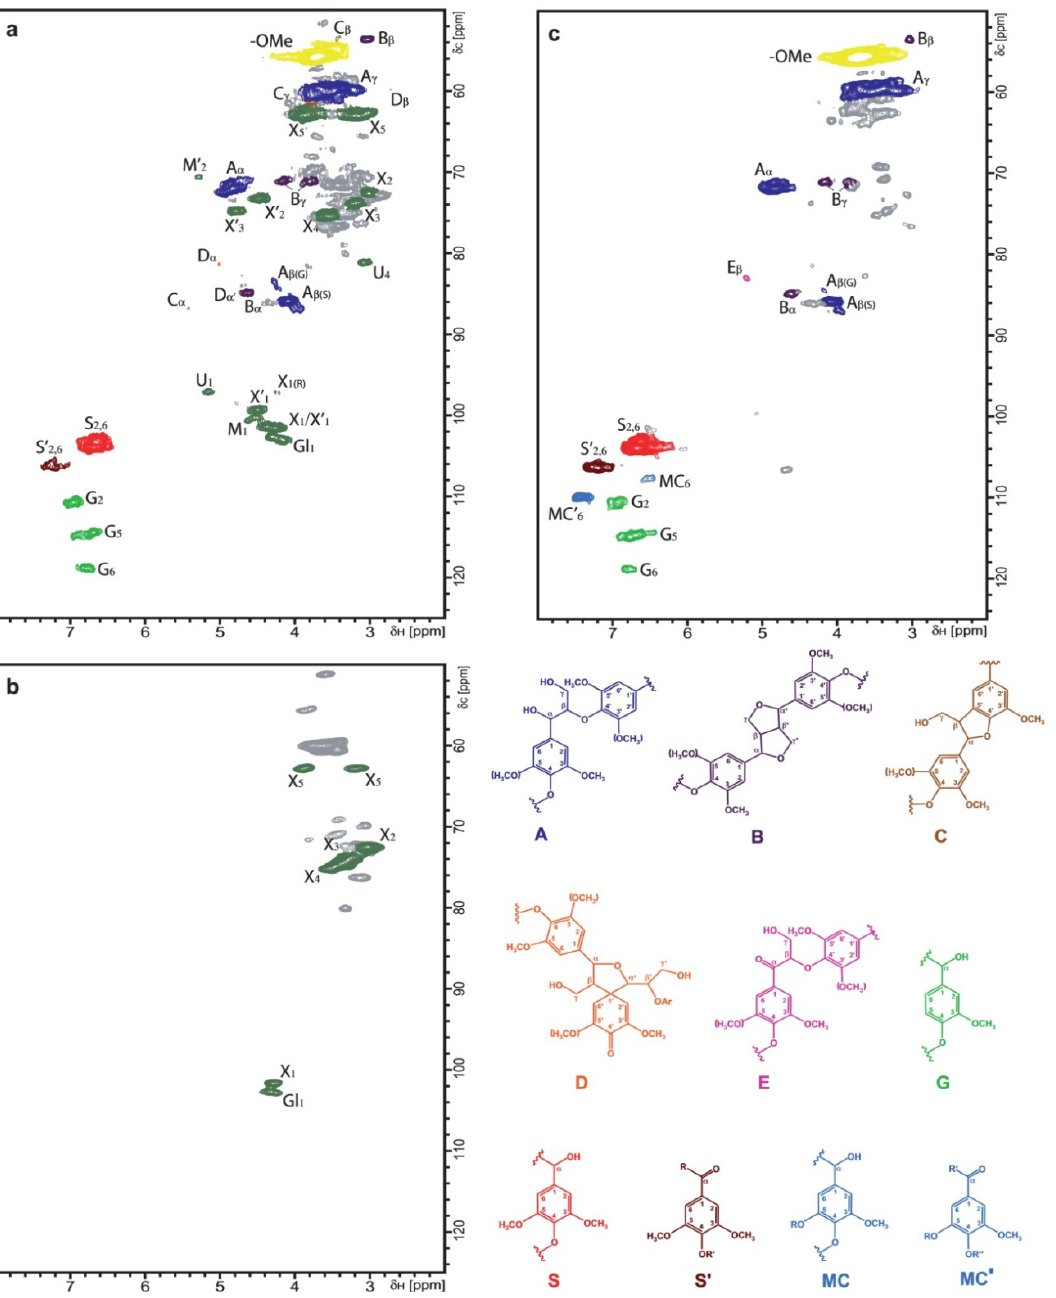
Figure 11. Two-dimensional (2D) NMR spectra (HSQC experiments) at the gel state of: ( a ) sound E. cordifolia wood; ( b ) E. cordifolia wood after selective white-rot fungal decay under environmental conditions (by G. australe); and ( c ) E. cordifolia wood after selective brown-rot fungal decay under environmental conditions. The lignin structures identified are also shown: ( A ) β -O-4' substructure; ( B ) resinol substructure; ( C ) phenylcoumaran substructure; ( D ) spirodienone substructure; ( E ) C -oxidized substructure A; ( G ) guaiacyl unit; α ( S ) syringyl unit; ( S ') C -oxidized S unit (R, lignin or OH; R ′, H or lignin); α ( MC ) 5-hydroxyguaiacyl (R, H) or 5-aryl-ether-guaiacyl unit (R, lignin aromatic ring); ( MC ') C -oxidized MC unit (R', lignin or OH; R'', H or lignin); The carbohydrates identified α are also shown (X) β -xylan units; ( U ) α -glucuronic acid; ( G1 ) β -glucan (Reprinted from [81]. Copyright 2011